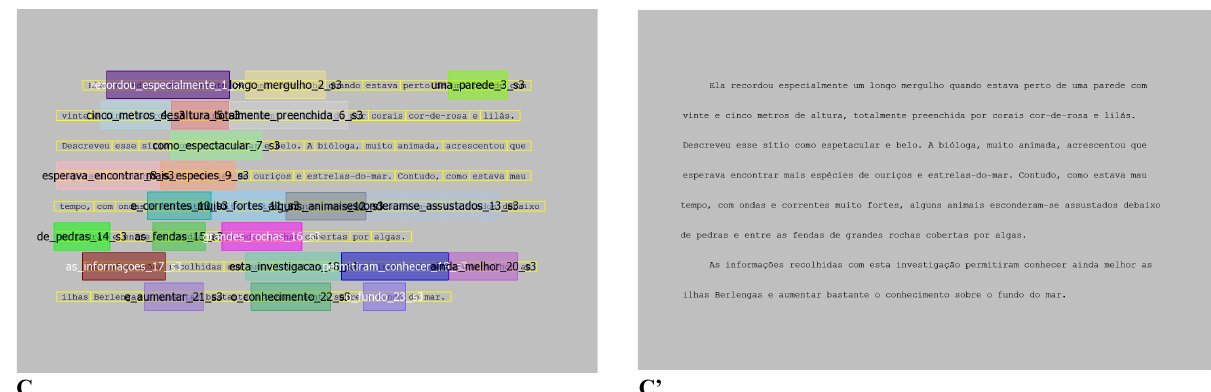
Figure 1 – Reading task. A , B , and C are respectively 1 st , 2 nd and 3 rd slides with coloured rectangles representing AOI / Target words. A’ , B’ and C’ are respectively 1 st , 2 nd and 3 rd slides with embedded target words. Total number of words =